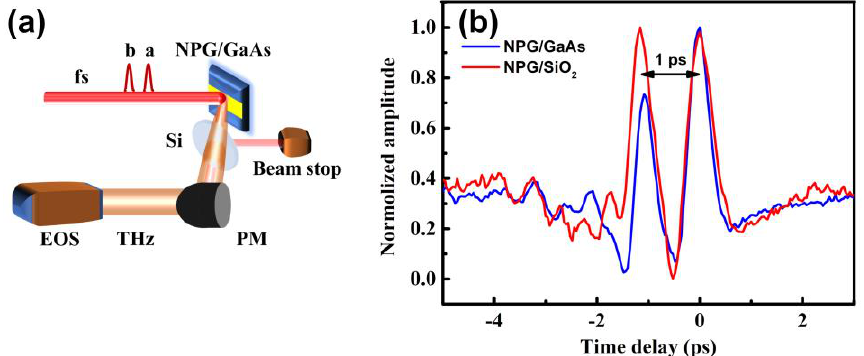
Figure 4. ( a ) Schematic diagram with two collinearly-propagating pulses (pulse-a and pulse-b) to irradiate on the surface of the NPG films. Pulse-a was 1 ps ahead of pulse-b. The emitted THz waveforms were detected by EOS sampling; ( b ) Normalized THz waveforms from NPG/GaAs and NPG/SiO 2 .